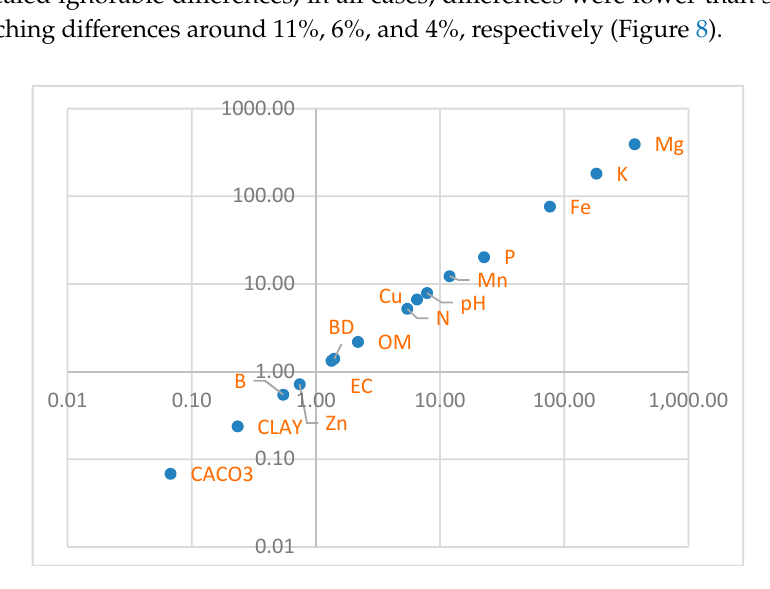
Figure 8. Log-log plot of means of the sample set and the surfaces per soil property.